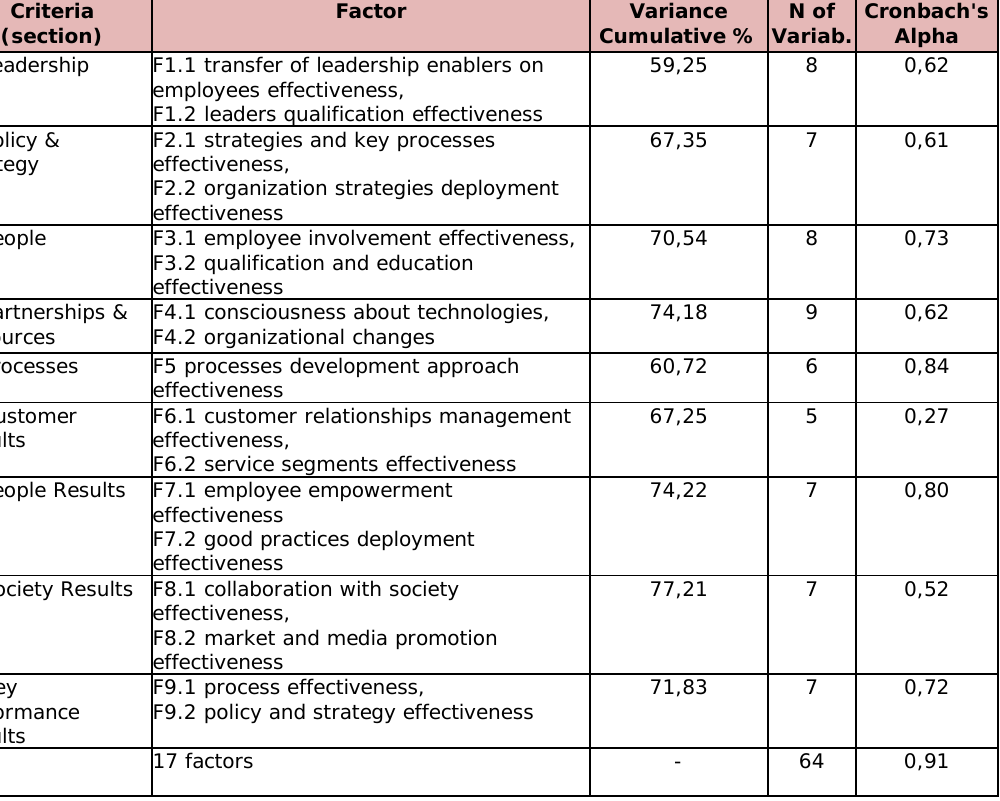
Table 2. “Solutions of the Factor Analysis”. Source: Dolinšek and Janeš